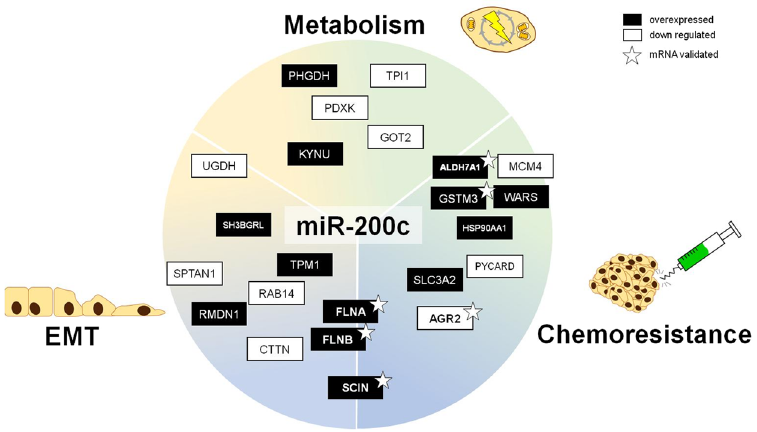
Figure 6. Summary of important pathways and biological phenotypes, with targets from Tables 1–3 matched to their known